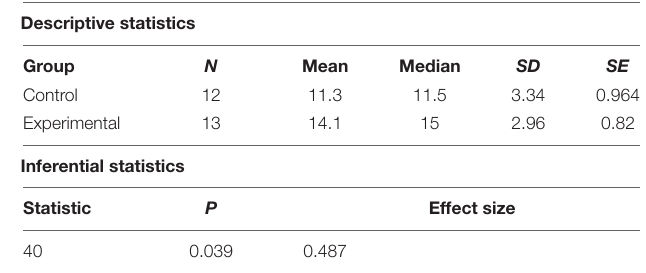
TABLE 4 | Mann-Whitney U